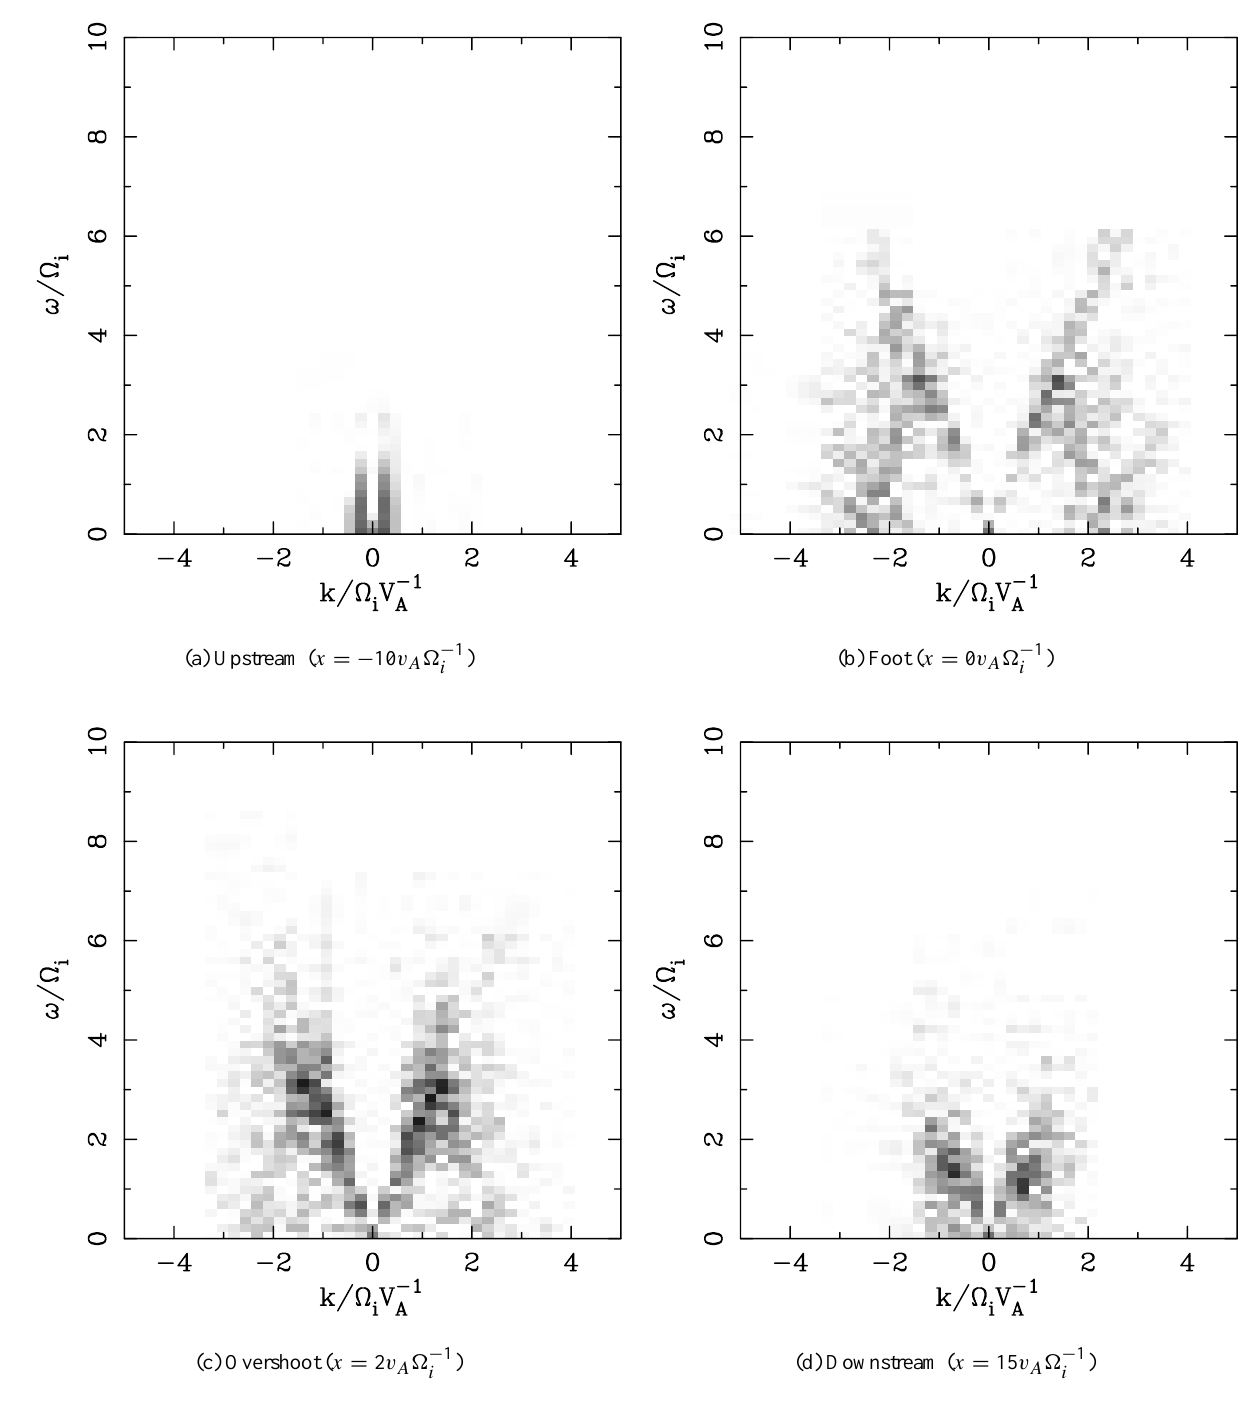
= 88 ◦ and M A ≈ 5 . 7. The high n